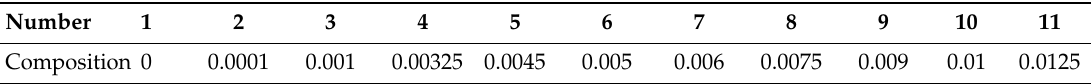
Table 3. Chemical composition of nanoparticles doped into the fluxes (wt.%).